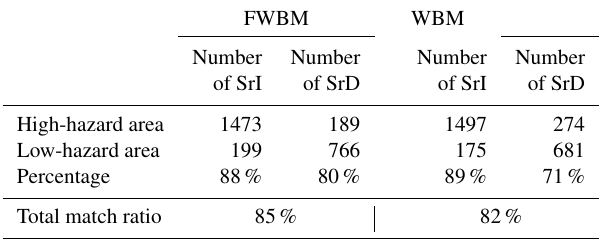
Table 1. Comparison of the match ratio (calculated by the ratio be- tween the sum of the amount of SrI in the high-hazard area and SrD in the low-hazard area, and the total number of SrI and SrD) obtained with FWBM and WBM.